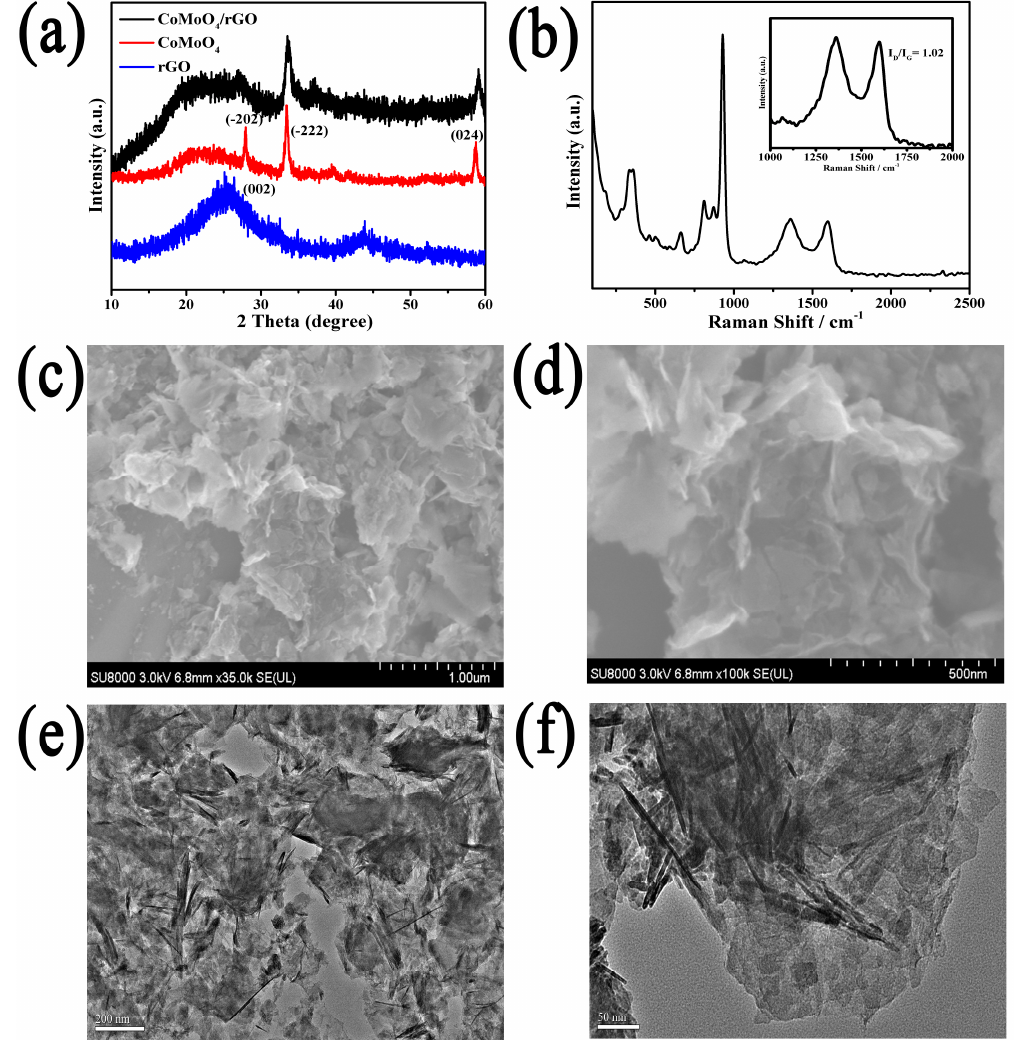
Figure 1. ( a ) X-ray Powder Diffraction (XRD) patterns of CoMoO 4 /rGO, CoMoO 4 and rGO powder samples; ( b ) Raman spectra. GO: graphene oxide. ( c , d ) SEM images of CoMoO 4 /rGO. ( e , f ) TEM images of CoMoO 4 /rGO.